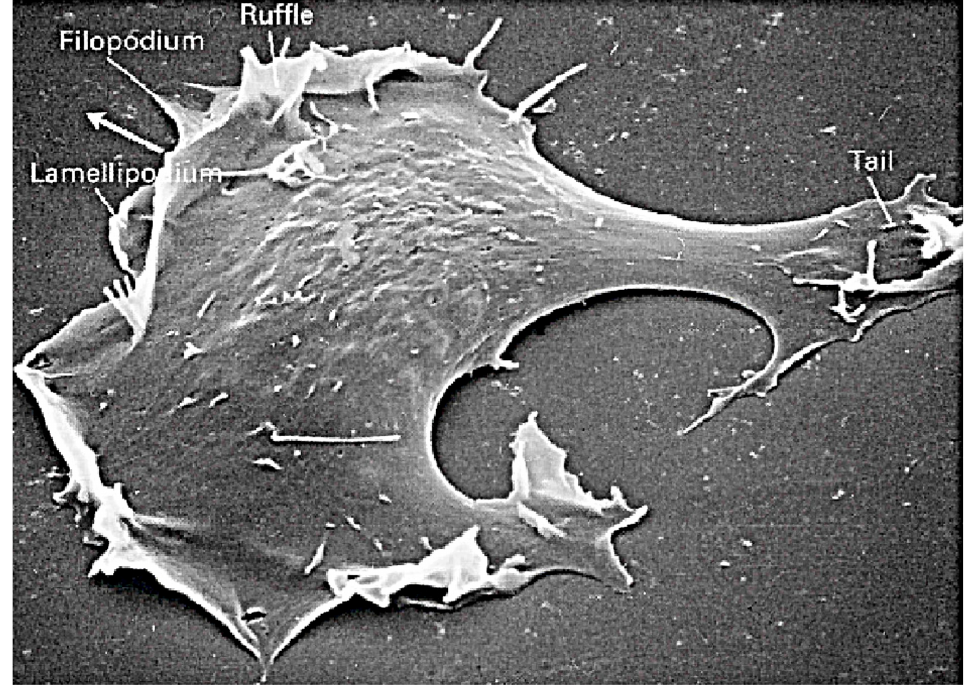
Figure 1. A fibroblast cell on a